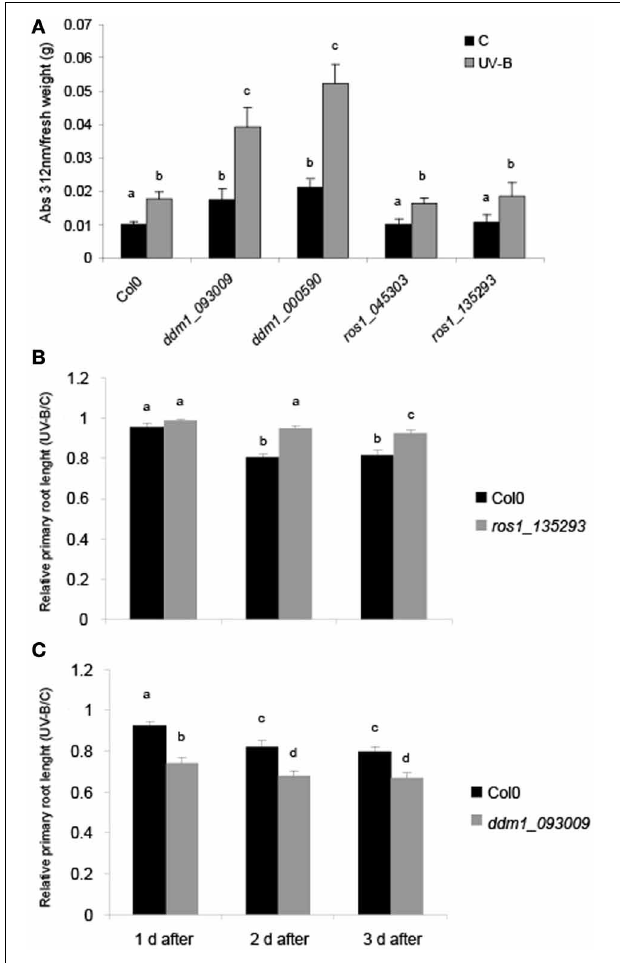
FIGURE 1 | Physiological responses in ddm1 and ros1 mutants after UV-B exposure. (A) Total UV-B absorbing compounds were assayed after 4h UV-B (UV-B) compared to untreated controls (C) in Col0 plants, and ddm1 and ros1 mutants. Measurements are the average of six adult leaves from six different plants. ( B and C ) Graph of average root lengths in Col0, ros1 (B) and ddm1 (C) mutants up to 3 days after a UV-B treatment. Error bars represent S.E.M. Statistical significance was analyzed using ANOVA, Tukey test with P < 0 . 05; differences from the control are marked with different